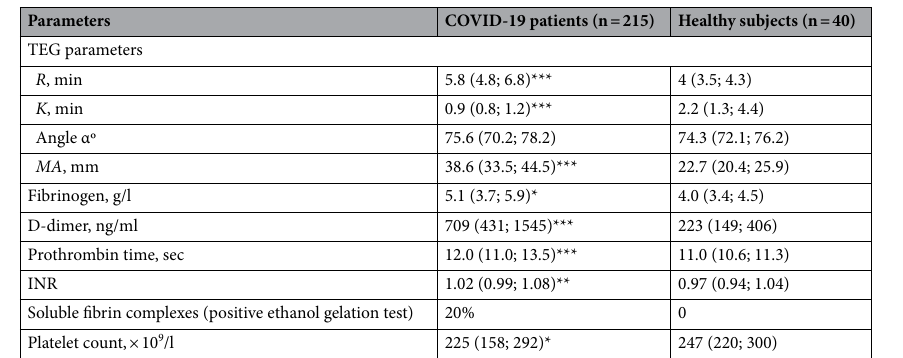
Correlation analysis of the thrombo- dynamics parameters and laboratory signs of inflammation revealed important connections (Table S1). A posi- tive correlation was found between the clot optical density and CRP and erythrocyte sedimentation rate (ESR); the clot size correlated positively with the blood monocyte counts. A direct correlation was found between interleukin-8 and the initial velocity of clot formation and clot size. The abnormally high levels of interleukin-8 (> 10 pg/ml) were associated with higher initial rates of clot growth with a median of 54.4 μm/min (IQR 51.3; of IL-8-producing innate immune cells. An increase in CRP > 10 mg/l was paradoxically associated with a decrease in the clot growth rates and intermediate clot size as well as with prolonged lag time (Table 1e). A combination of hypocoagulability with the high levels of CRP in the blood agrees with the ability of CRP to decelerate blood clotting in vitro by blocking procoagulant phospholipids 15,16 . Concomitantly with increased levels of CRP > 10 mg/l, the clot optical density increased, reflecting hyperproduction of fibrinogen, which is, like CRP, an acute phase protein, and both are upregulated by interleukin-6 17 . A related finding was that the initial rate of clot growth was significantly smaller in patients with abnormally elevated levels of anti-cardiolipin antibodies (Fig. S2) and the two parameters cor- related inversely (r = -0.39; p = 0.0081). Thus, there is close relationship between coagulopathies and inflamma- tion in COVID-19.